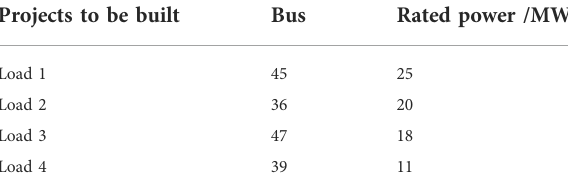
TABLE 3 Basic data of projects to be built on the load side. Projects to be built